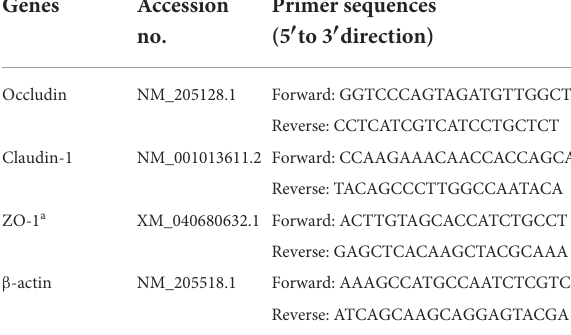
TABLE 4 Information on target genes and